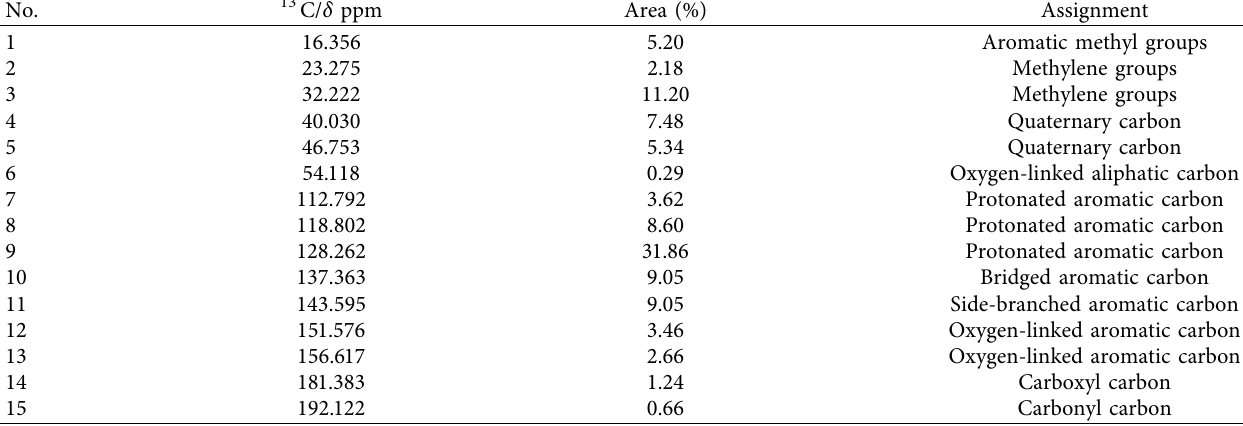
Table 3: Percentages of different carbon types in 13 C-NMR spectra of the coal dust.